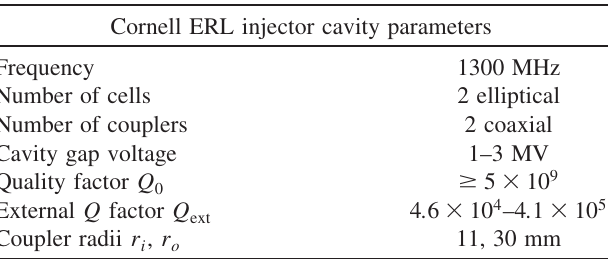
TABLE I. List of cavity parameters [5].